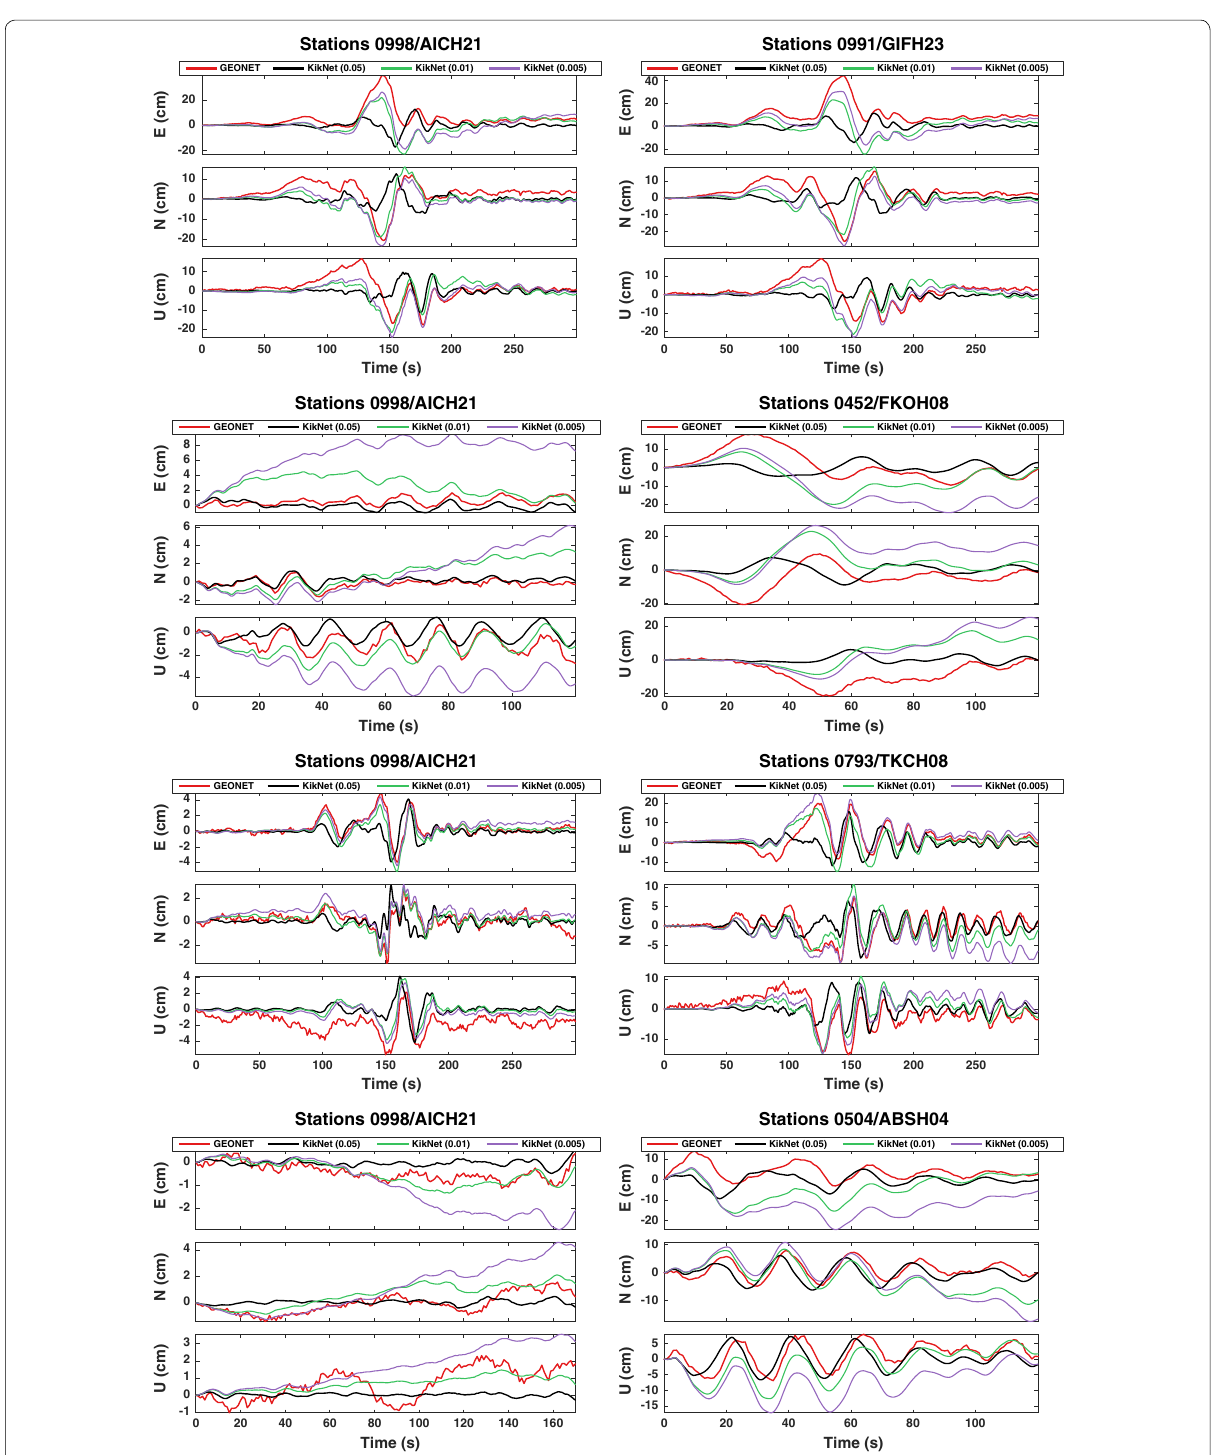
Fig. 7 The seismic waveforms of the KiK-net stations (AICH21, GIFH23, FKOH08, TKCH08 and ABSH04) from high-pass filtering and integrating the borehole KiK-net seismograms with different threshold frequencies (0.005, 0.01 and 0.05 Hz), together with the GPS PPP waveforms of the corresponding closest GEONET stations. The waveforms of the main shock at 14:46 and three immediate aftershocks at 14:51, 15:15 and 15:26 at the KiK-net station AICH21 (almost collocated with the GEONET station 0998) are shown on the left panel. The right panel shows the waveforms of the main shock at the KiK-net stations GIFH23, FKOH08, TKCH08 and ABSH04, almost collocated with the GEONET stations 0991, 0452, 0793 and